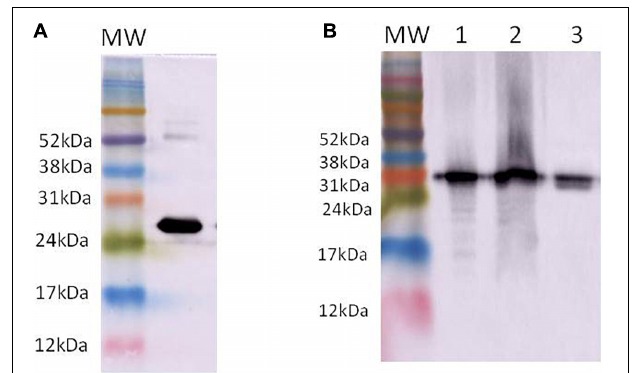
FIGURE 1 | Western blotting presenting the recognition of recombinant mTXNPx (A) and native mTXNPx (B) present in the soluble antigen from L. amazonensis (1), L. braziliensis (2), and L. guyanensis (3) by anti-mTXNPx monoclonal antibody. Molecular weight (MW) markers: Amersham ECL Rainbow Markers (GE Healthcare, Chicago, IL, United